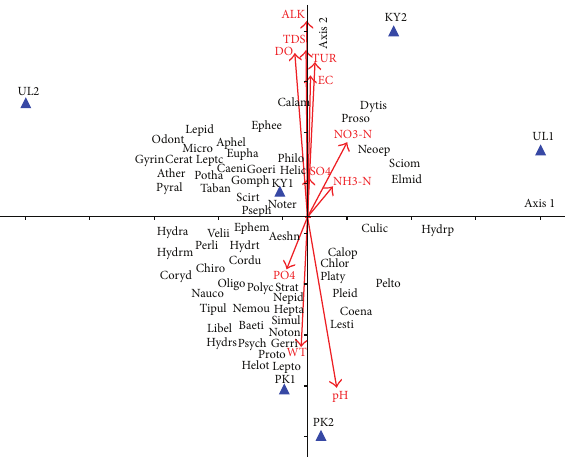
Figure 3: Biplot of the PCA ordination diagram for the data set between aquatic insect taxa, sampling sites, and environmental variables in the three streams. Abbreviations of taxa are shown in Table